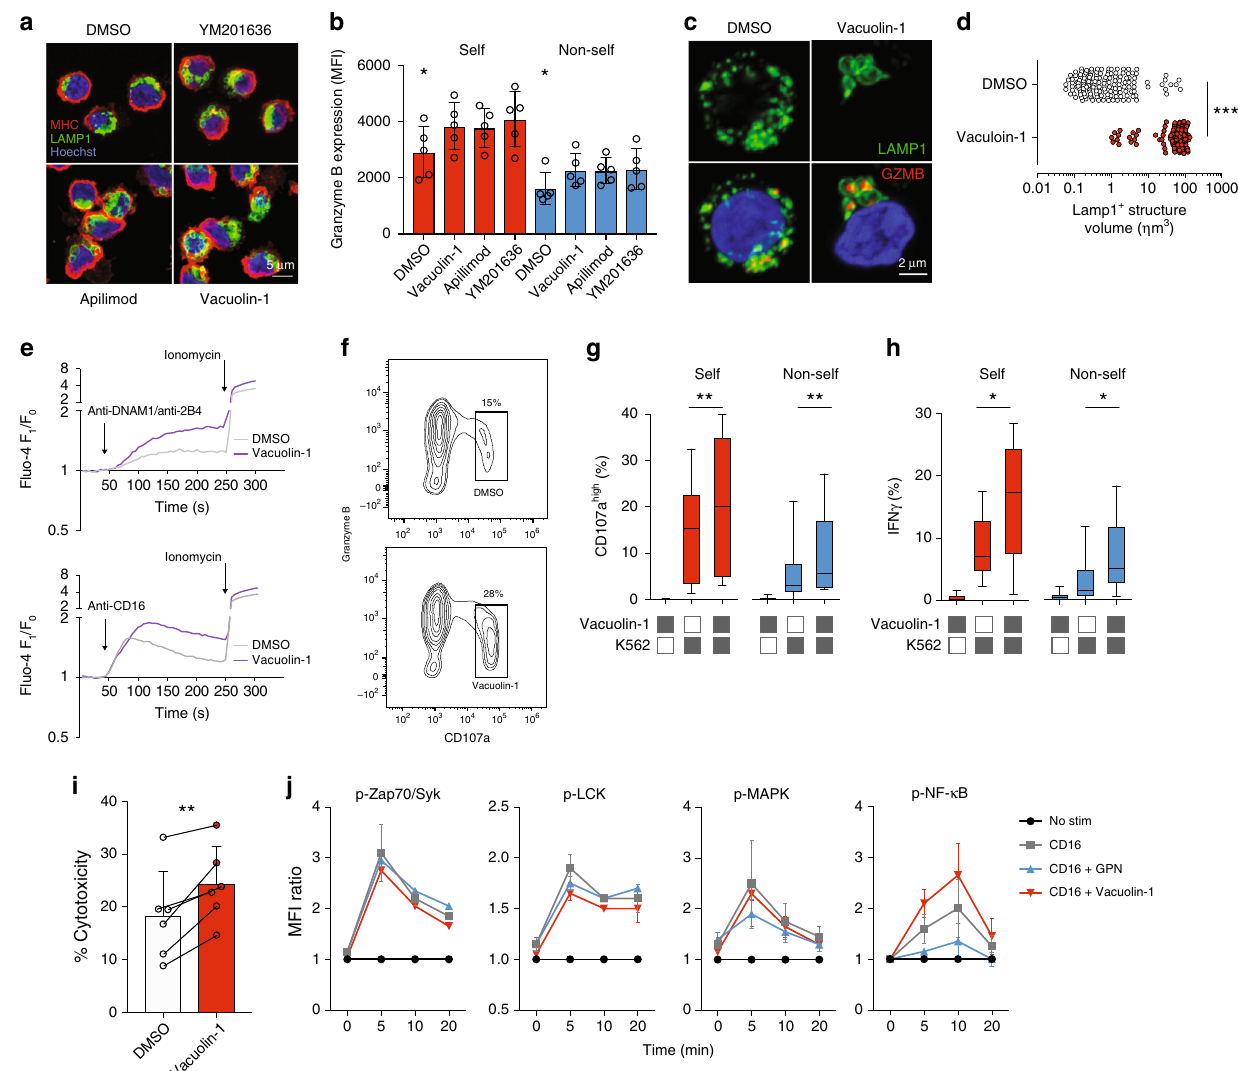
Fig. 6 Enlarging the secretory lysosomes leads to enhanced NK cell function. a Confocal Z-stack showing MHC-I, LAMP-1, and granzyme B (GZMB) staining in primary NK cells following PIKfyve inhibition using overnight incubation with 1 μ M vacuolin-1, 1 μ M apilimod, or 1 μ M YM201636. Scale bar is 5 μ m. b Intracellular granzyme B expression in self-KIR + and non-self-KIR + NK cells following overnight incubation with the indicated PIKfyve inhibitor assessed by fl ow cytometry ( n = 5 independent donors). c Representative example of a confocal image of primary NK cells treated overnight with 1 μ M vacuolin-1 or DMSO. Scale bar is 2 μ m. d Compiled confocal data on the volume of LAMP-1 + structures from cells treated overnight with DMSO or vacuolin-1 ( n = 149 LAMP-1 + structures). e Cytosolic Ca 2 + - fl ux in NK cells in response to stimulation with biotinylated anti-DNAM-/2B4 (top) or anti- CD16 (bottom) crosslinked with streptavidin at the indicated timepoint. Cells were treated with 10 μ M vacuolin-1 added directly before the assay and then maintained throughout the incubation time. f Representative FACS histogram of granzyme B versus CD107a expression following stimulation with K562 cells in the presence of DMSO or 10 μ M vacuolin-1. g Frequency of CD107a high + and h IFN γ + self-KIR + and non-self-KIR + NK cells after stimulation with K562 in the presence of DMSO or 10 μ M vacuolin-1. i FACS-based killing assay showing NK cell killing of K562 cells after treatment with DMSO or 10 μ M vacuolin-1 ( n = 6 donors). j Relative phosphorylation of the indicated signaling molecules following stimulation with biotinylated anti-CD16 (10 μ g/mL) crosslinked with streptavidin in the presence of 50 μ M GPN or 10 μ M vacuolin-1. Friedman ’ s test was used in panel ( b ). A non-paired t -test was used in panel ( d ). Paired t -test was used in panels ( g – i ). Whiskers show 5th to 95th percentile. Bars show the median. **** p < 0.0001; ** p < 0.01; and * p < 0.05. Red and blue circles and box plots represent NK cells with self or non-self KIR, respectively. In panels ( i ) and ( j ), red and blue colors indicate cells treated with the indicated